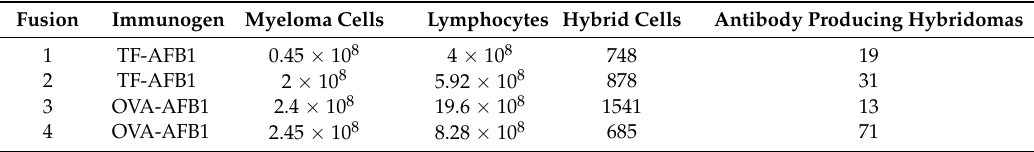
Table 2. Hybridoma fusion conditions and